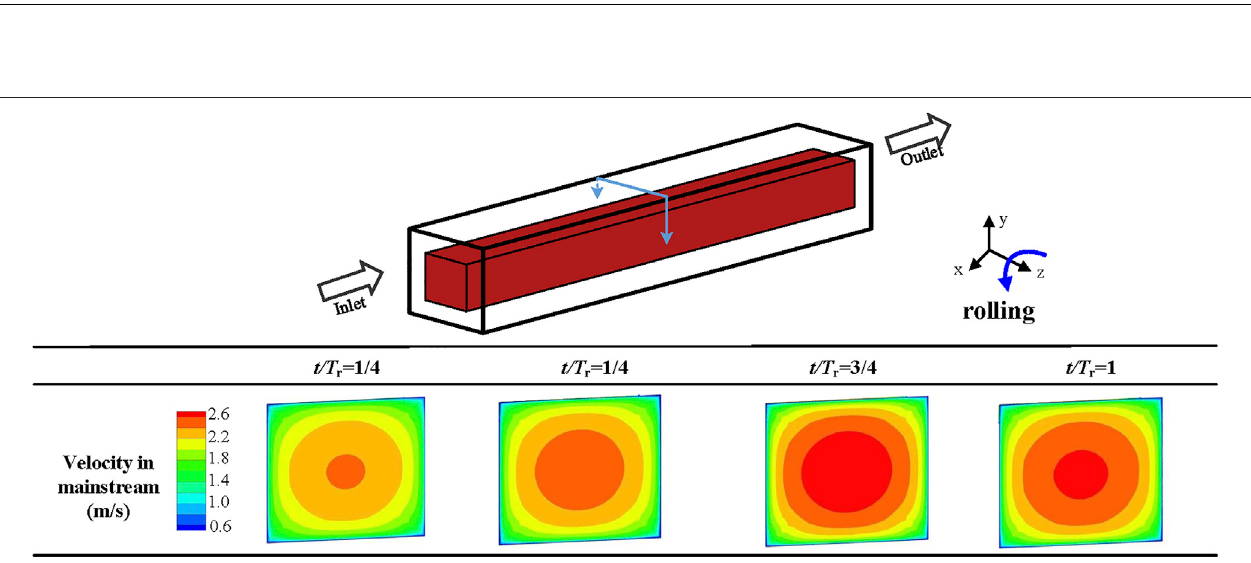
FIGURE 8 | Effect of sloshing on the fl ow fi eld in the mainstream direction (Chen et al., 2022).